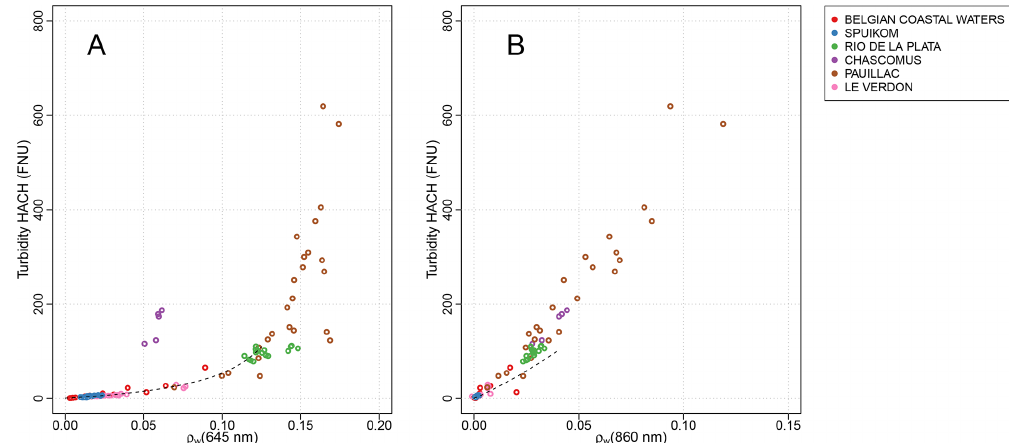
Figure 9. Turbidity as a function of water reflectance at 645nm (a) and 850nm (b) . Black dotted line represents the model of Nechad et al. (2009) between 0 and